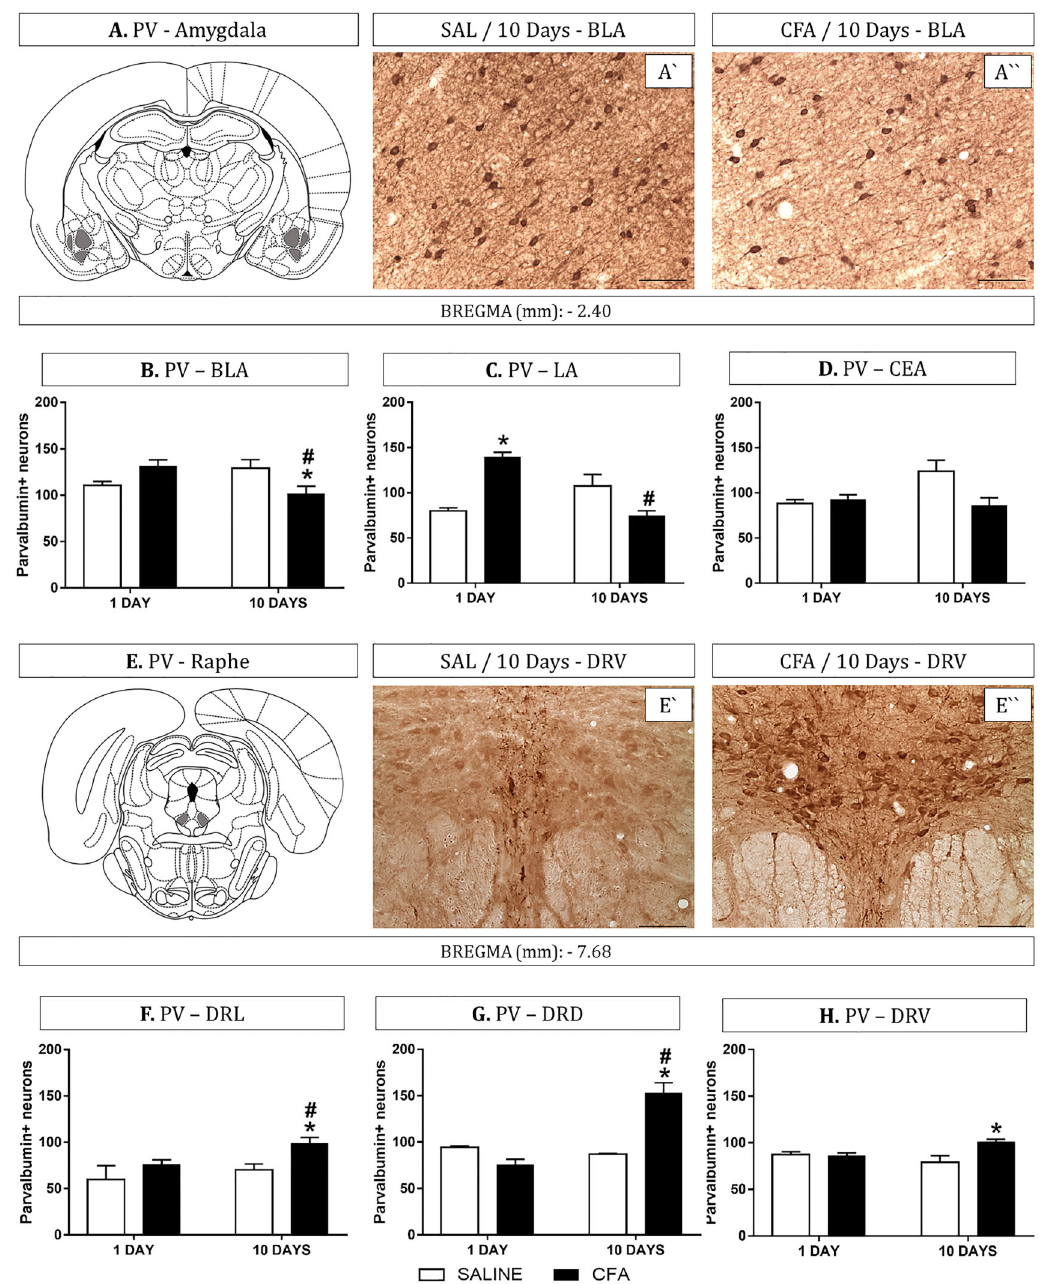
Figure 2. Subregions of the amygdala and dorsal raphe nucleus were analyzed for parvalbumin (PV) expression in complete Freund ’ s adjuvant (CFA)-induced temporomandibular in fl ammation (1 or 10 days) and rats administered saline (SAL) (n=6 – 7 per group). A , Plate adapted from Paxinos and Watson Atlas (26; Elsevier Academic Press) of basolateral nuclei of the amygdala (BLA); A ’ , photomicrograph of PV staining in the BLA of a representative rat from the Day 10/saline-treated group and A ’’ , from the Day 10/ CFA treated group. Graphs show PV immunohistochemistry (IR) quanti fi cation in basolateral (BLA - B ), lateral (LA - C ), and central nuclei of the amygdala (CEA - D ) ( – 2.40 mm bregma). E , Plate adapted from Paxinos and Watson Atlas (26; Elsevier Academic Press) of the lateral division of the dorsal raphe nucleus (DRL); E ’ , photomicrograph of PV IR in the DRV of a representative rat from the Day 10/saline-treated group and E ’’ , from the Day 10/CFA-treated group. Graphs show PV IR quanti fi cation in lateral (DRL - F ), dorsal (DRD - G ), and ventral (DV - H ) divisions of the dorsal raphe nucleus ( – 7.68 mm bregma). Data are reported as means ± SE. *P o 0.05 vs Day 10/control group (saline), # P o 0.05 vs Day 1/CFA group (Newman-Keuls test). Magni fi cation, 20 (cid:3) ; scale bars, 100 m